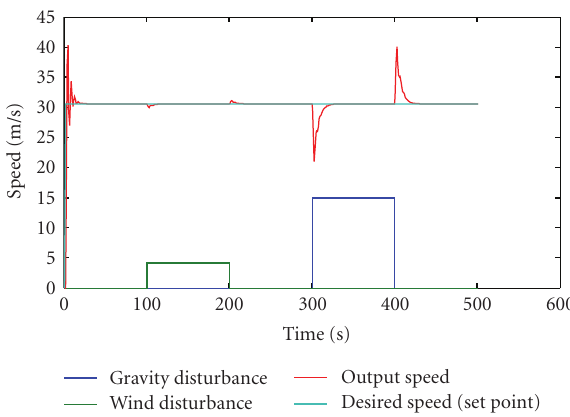
Figure 7: Response of speed for nonlinear model.